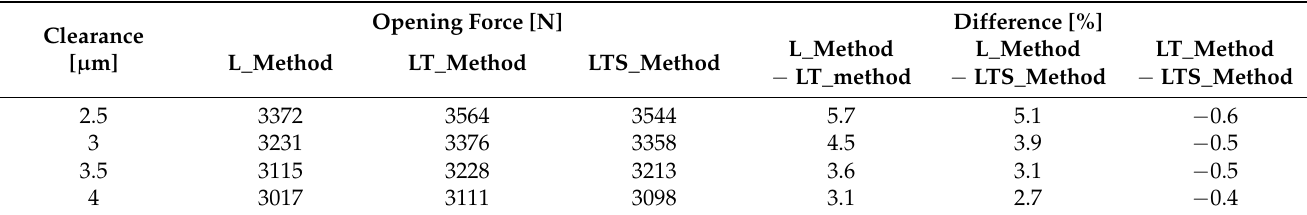
Table 6. Opening force according to clearance with an outer pressure of 6 bar.